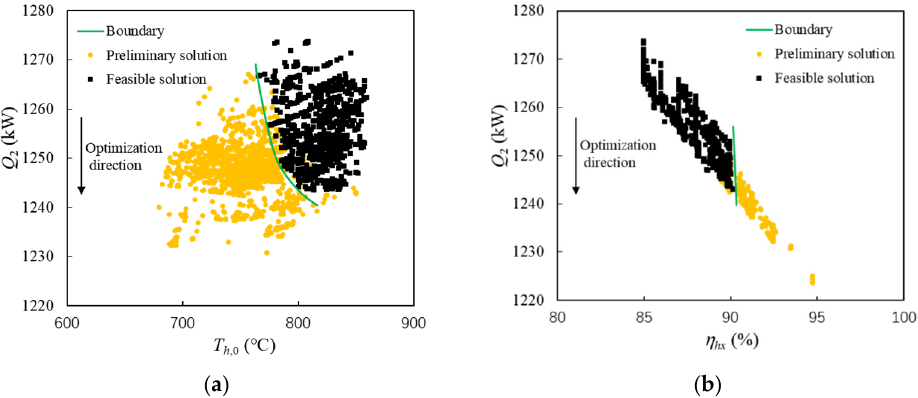
Figure 9. Relationship of T h ,0 , η hx and Q hs in feasible solutions. ( a ) Hot side inlet temperature boundary ( b ) Efficiency boundary.